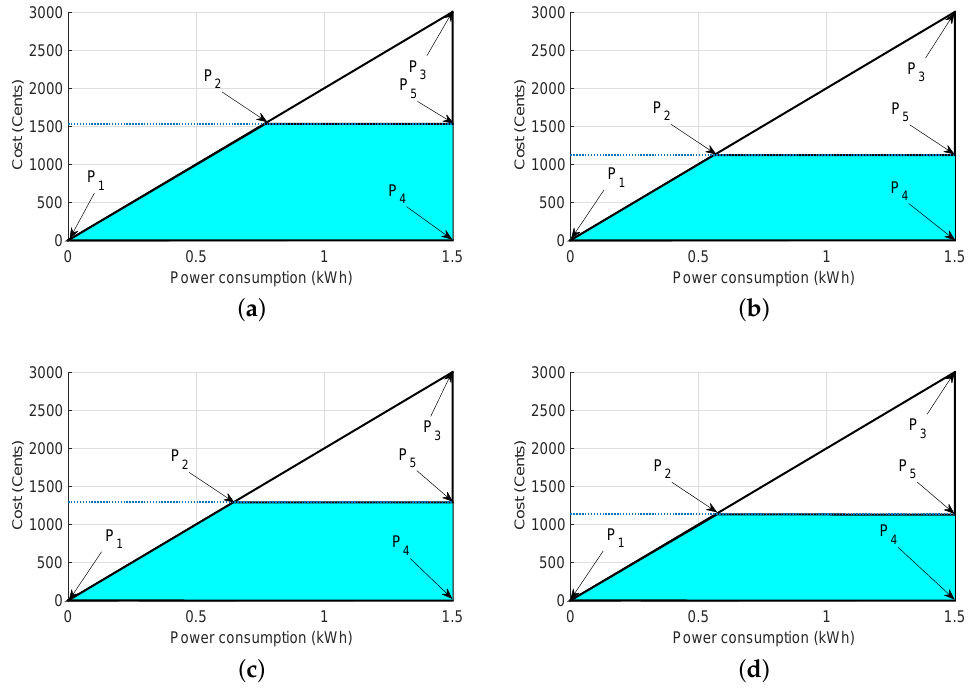
Figure 16. Feasible regions for a single home using critical peak pricing. ( a ) Operational time interval of 1 min; ( b ) Operational time interval of 20 min; ( c ) Operational time interval of 30 min; ( d ) Operational time interval of 60